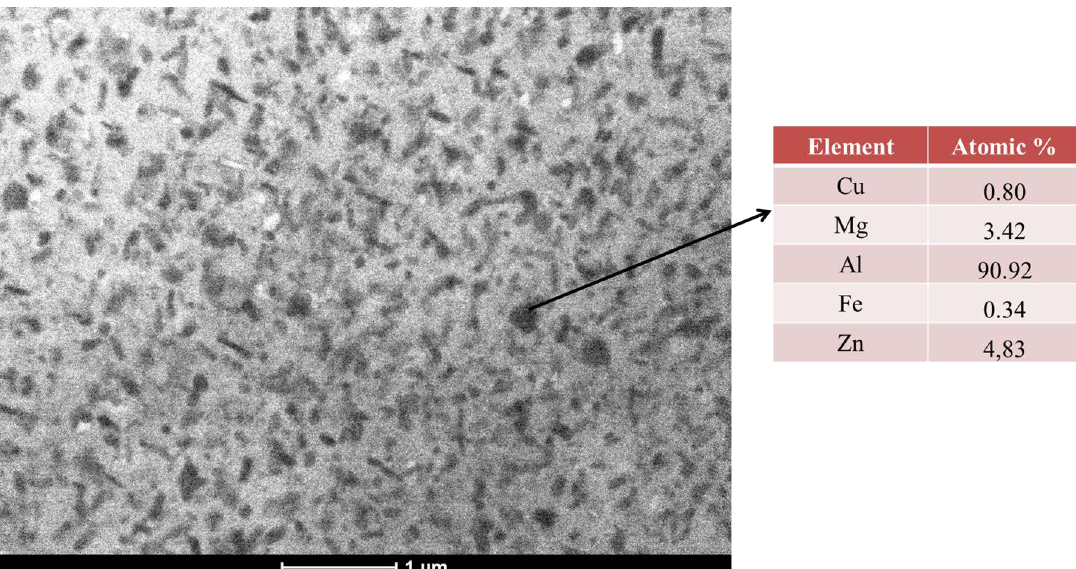
coarsening and particles volume fraction increasing after AA 7075 overaging (300°C and 2